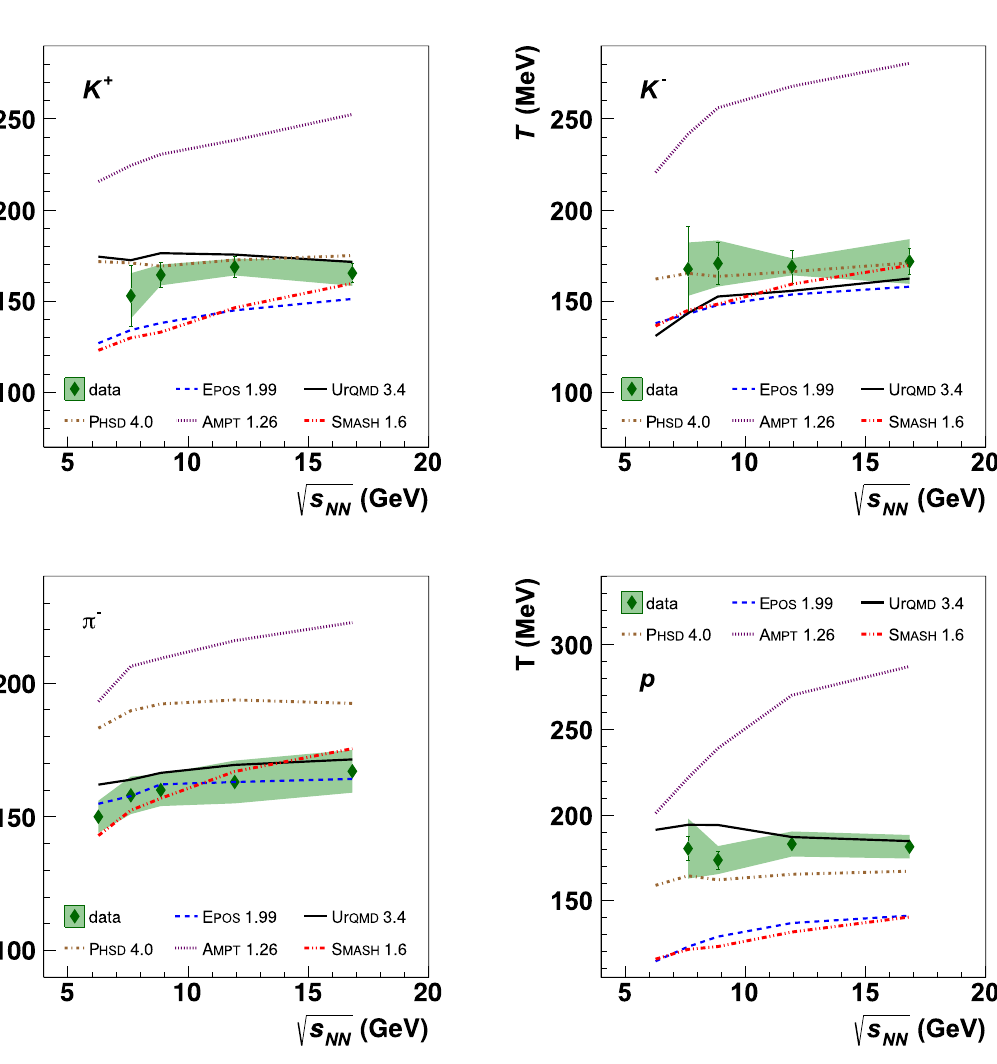
Fig. 36 Comparison of the energy dependence of the inverse slope parameter T of K + (top-left), K − (top-right), π − (bottom-left) and p (bottom-right) spectra at mid-rapidity for the 20% most central Be+Be